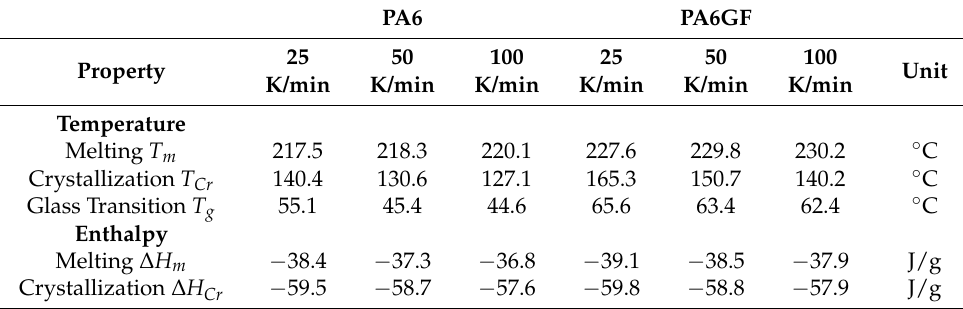
Figure 4. DSC thermograms: cooling steps at different rates. Table 3. Thermal properties of PA6